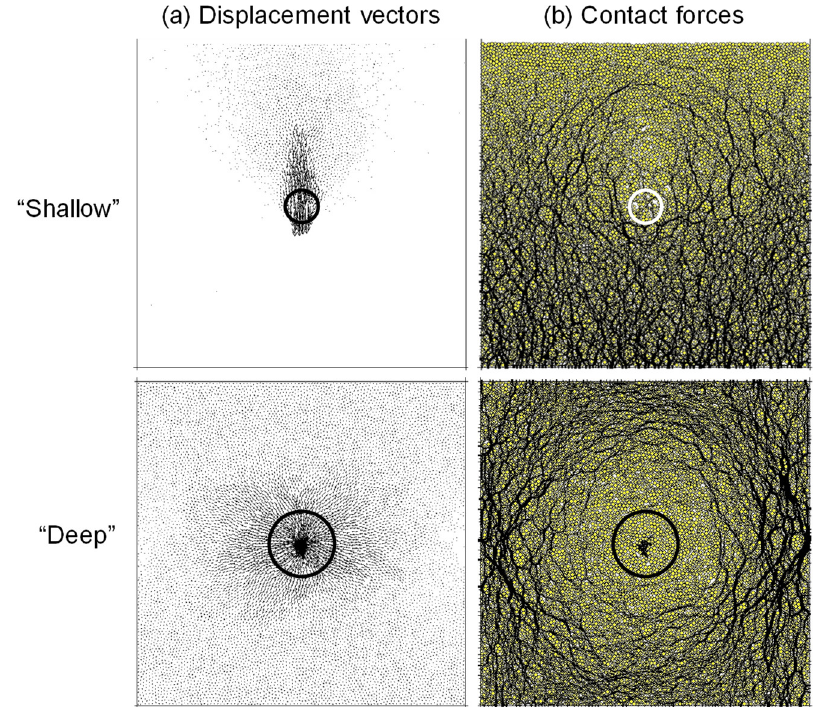
Figure 7. Shallow versus deep volume loss. ( a ) Displacement vectors and ( b ) contact forces after dissolution. The deep inclusion is subjected to constant vertical stress of 100 kPa, and both the top and bottom boundaries move in as the inclusion contracts. The circles show the original size of the contracting zone. Note: HR = 40% in both cases.